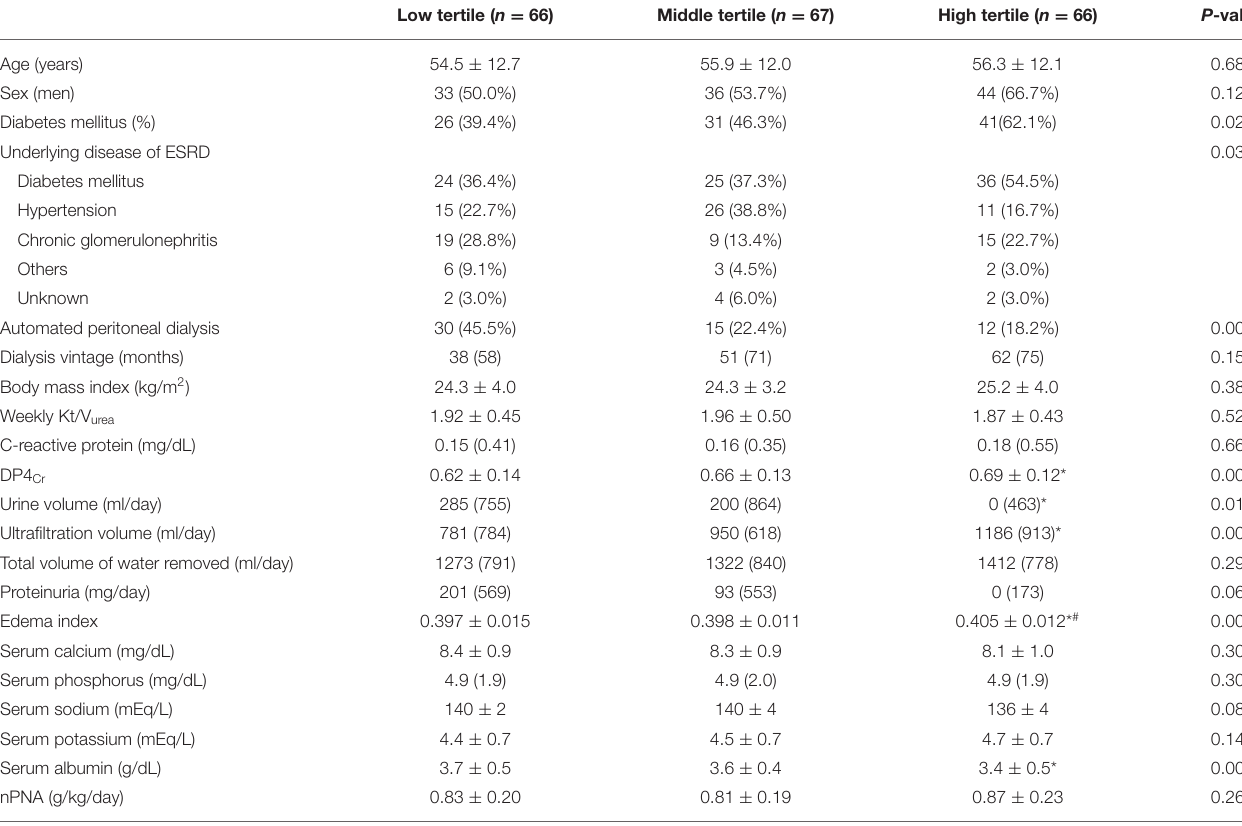
TABLE 1 | Patients’ clinical